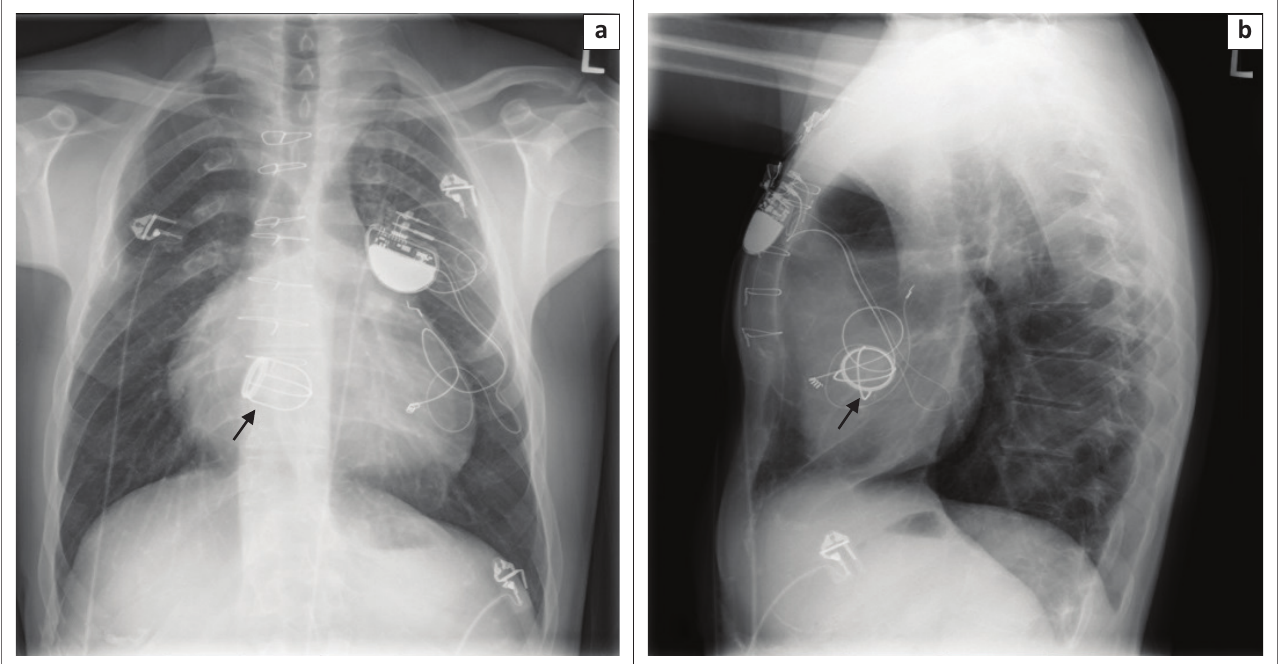
FIGURE 18: Frontal (a) and lateral (b) chest radiographs showing an isolated prosthetic tricuspid valve replacement (Starr Edwards valve) (arrow) in a 51-year-old male patient with a history of Ebstein’s anomaly. Note the implanted pacemaker with its epicardial leads.